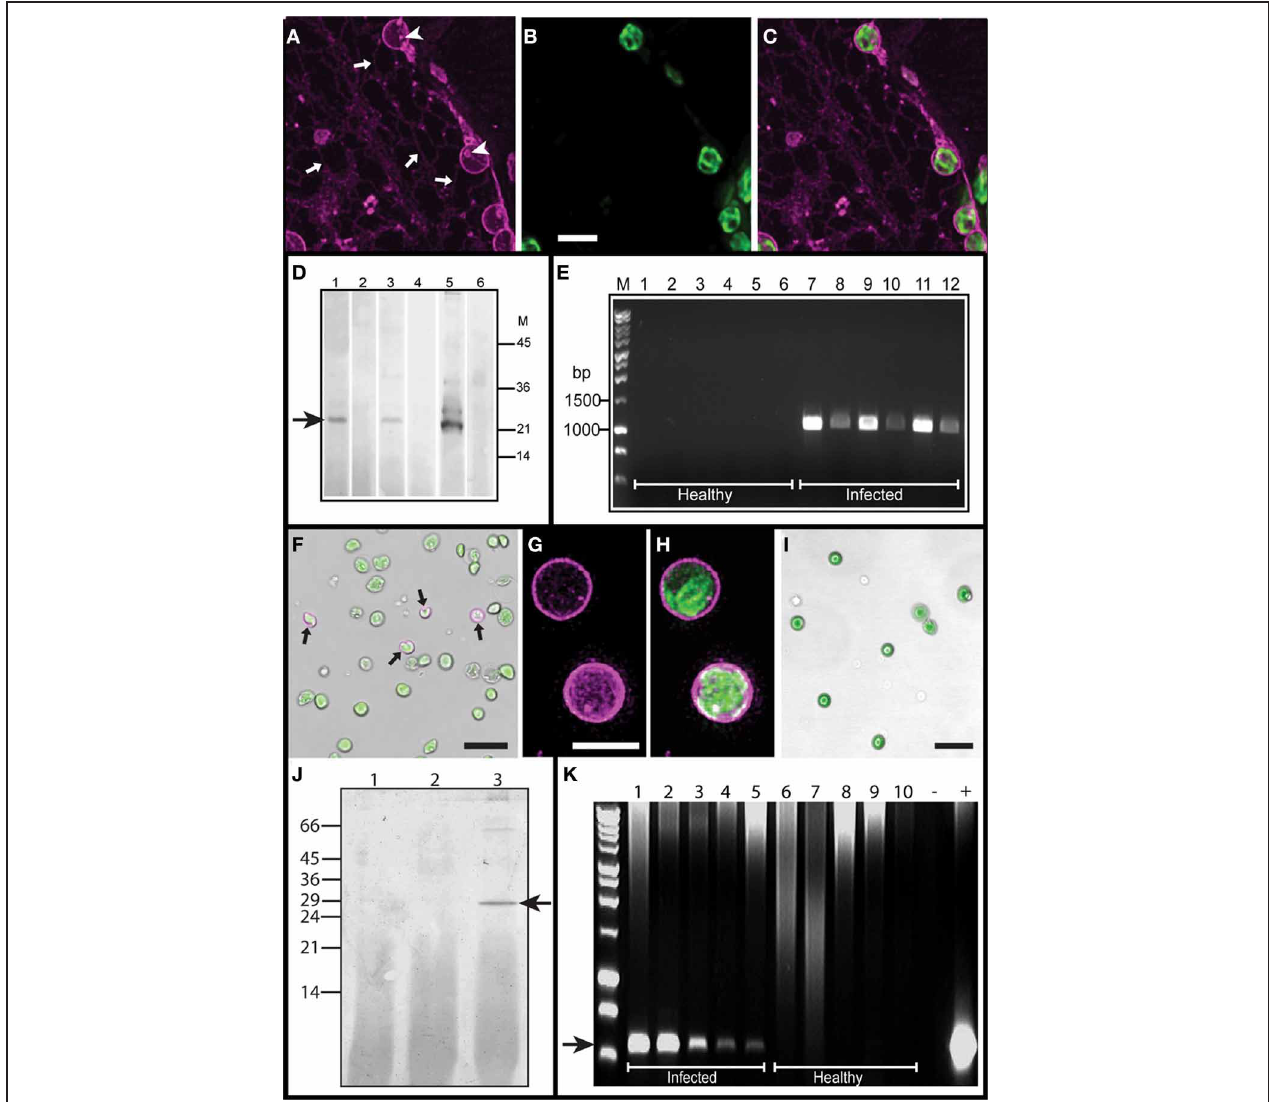
FIGURE 3 | Analysis of TGB2 protein associated with chloroplasts. (A,B,C) Deconvolved images showing mRFP-TGB2 (in magenta; A ) in the membrane of chloroplasts, in strands of the ER network (arrows) and in small bodies on the ER. Chlorophyll autofluorescence is shown in green (B) . TGB2 is also present at a low level in the stroma of the chloroplasts and in some foci on the surface of the plastids (arrowheads; A ). (C) shows an overlay of (A) and (B) . Bar in B = 5 μ m for (A–C) . (D) Western blot of plastid preparations from PMTV-infected (lanes 1, 3, 5) and non-infected (lanes 2, 4, 6) N. benthamiana leaves; the blot was reacted with anti-PMTV CP serum. Lanes 1 and 2, disrupted plastids and membrane fraction; lanes 3 and 4, intact plastids and lanes 5 and 6, non-fractionated preparation. Reaction with CP arrowed; the positions of the size markers (kDa) indicated on right. (E) RT-PCR of plastid preparations from non-infected (lanes 1–6) and PMTV-infected (lanes 7–12) N. benthamiana leaves. Total RNA was prepared from leaves (lanes 1, 2, 7, 8), intact plastid fraction (lanes 3, 4, 9, 10) or disrupted plastid and membrane fraction (lanes 5, 6, 11, 12). cDNA preparations from each sample were tested at dilutions of 1/10 and 1/100. Size markers indicated on the left. (F) False transmission and fluorescence image overlay of plastid preparation from N. benthamiana leaves infected with the TMV vector expressing GFP-TGB2. Chlorophyll autofluorescence is shown in green, while GFP-TGB2 on the plastid membrane is shown in